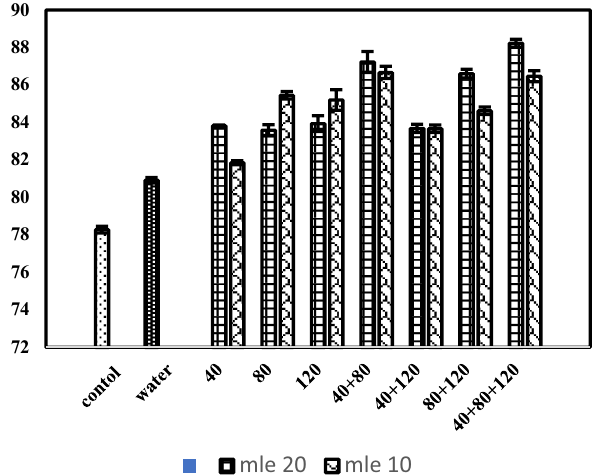
Figure 4. Iodine value (meq kg −1 ) of black cumin as affected by moringa leaf extract applied at various growth